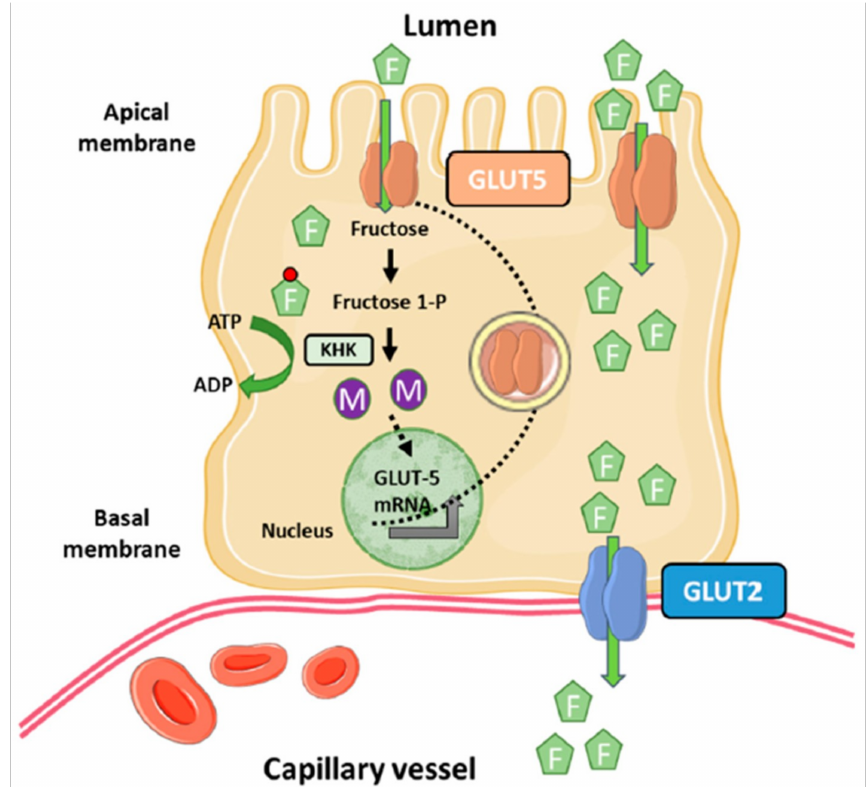
Figure 1. Fructose transport in the small intestine. Fructose ( F ) is transported by GLUT5 through the brush border membrane and enters cytosol of enterocytes, where it is rapidly phosphorylated by ketohexokinase(KHK),leadingtoarapiddepletionofintracellularATPlevels. Apoolofphosphorylated fructose is partially or totally metabolized yielding metabolites ( M ) that induce Slc2a5 gene expression. The remaining fructose is released across the basolateral membrane into portal circulation down the concentration gradient by GLUT2. In this conceptual model, the small intestine passively transport fructose to portal circulation and the liver is a major organ for fructose metabolism. This figure was created using Servier Medical Art (available at https: // smart.servier.com /